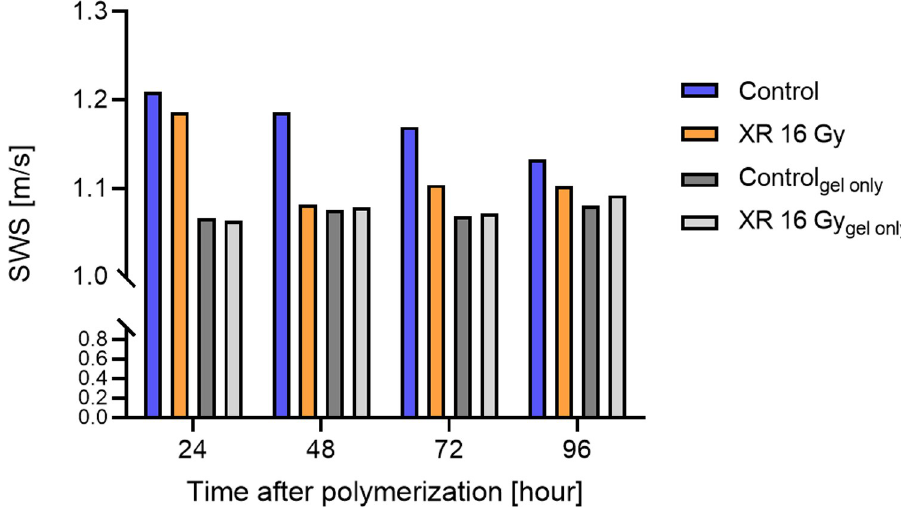
Fig 6. Temporal stiffness dynamics in samples without embedded cells and with cell-laden gels with or without XR at 24 hours.